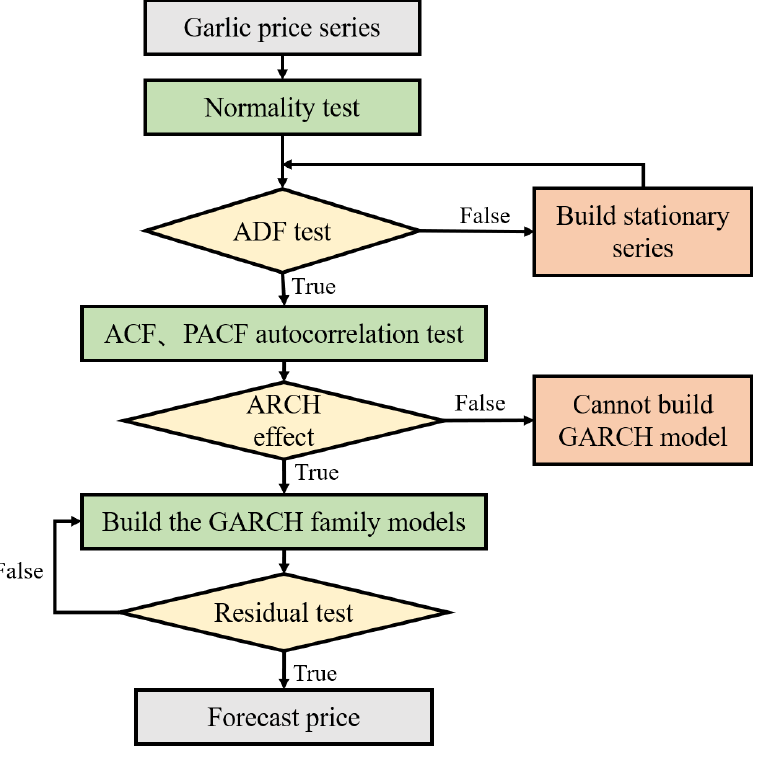
Figure 2. GARCH-family modeling